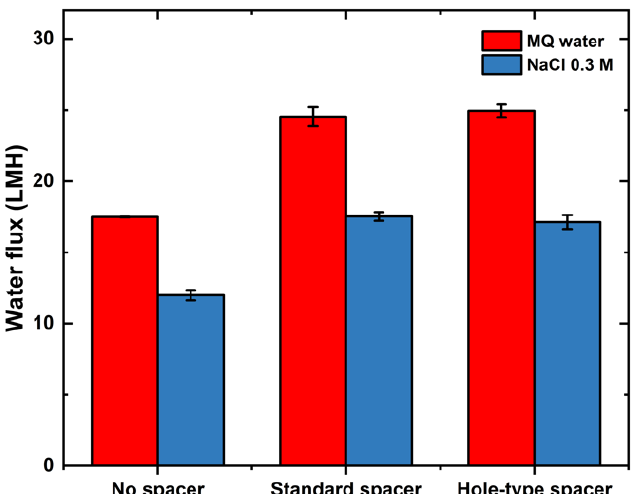
Figure 3. Water fluxes produced by using NaCl (1.2 M) as DS and different FS concentrations (Milli-Q water and NaCl (0.3 M)) in FO system.